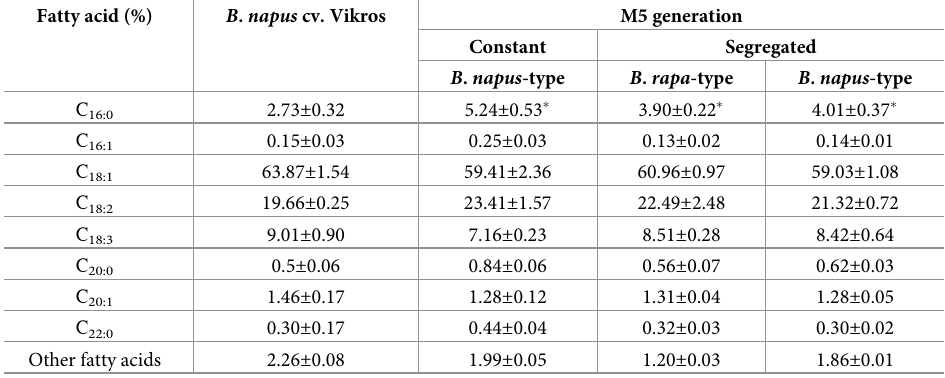
Table 2. Fatty acid composition of seeds in B . napus cv. Vikros and M5 plants. Fatty acid